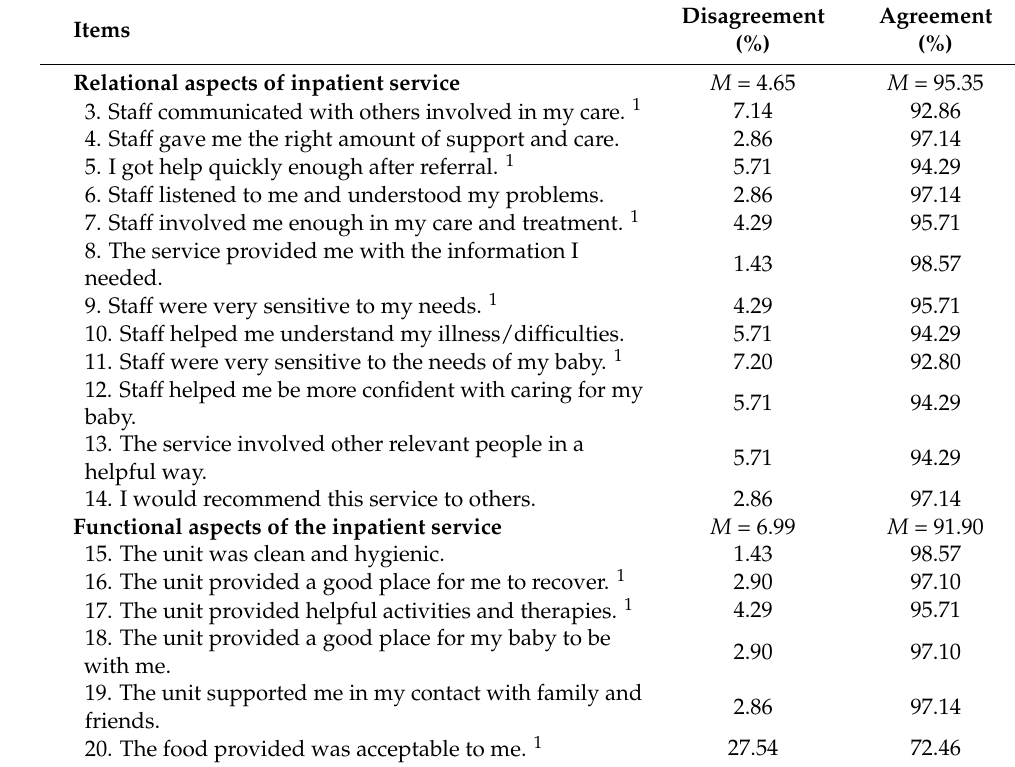
Table 3. Percentage of Agreement (Strongly Agree and Agree) and Disagreement (Strongly Disagree and Disagree) of Maternal-Rated Items from the